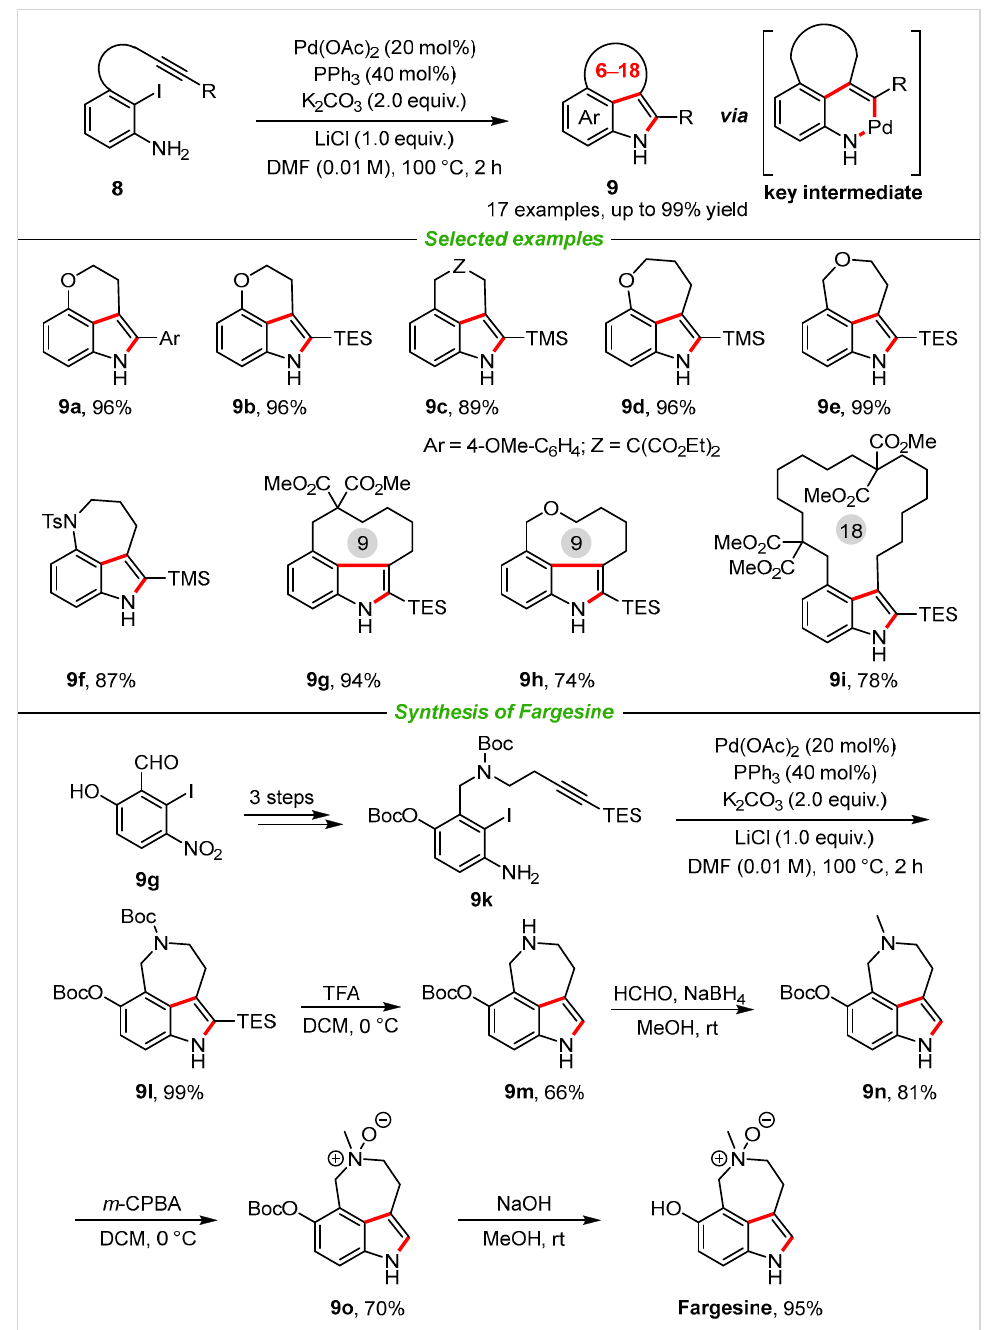
Scheme 5. Synthesis of 3,4-fused tricyclic indoles via palladium-catalyzed intramolecular annulation tion of internal alkyne tethered ortho -iodoanilines and total synthesis of fargesine. of internal alkyne tethered ortho -iodoanilines and total synthesis of The strategy of diversity oriented synthesis (DOS) is of great importance in organic synthesis, medicine chemistry, agrochemical chemistry, and material sciences, which aims to efficient collections of small molecules with diverse appendages, functional groups, stereochemistry, and skeletons [30]. In 2013, the You group [31] developed an efficient, Pd(0)-catalyzed allylic alkylation protocol for the synthesis of 3,4-fused tricyclic